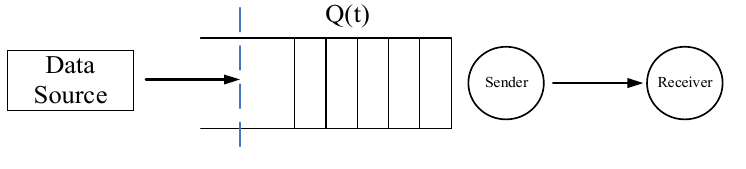
Figure 2. Queuing system model.